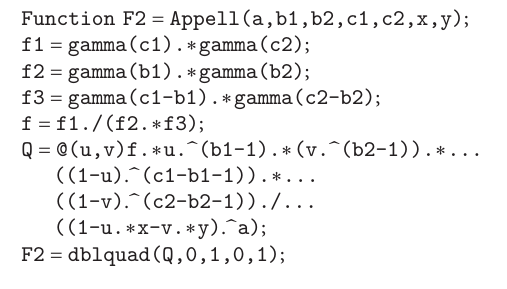
Algorithm 1: MATLAB Program for evaluating 𝐹 2 (⋅) .